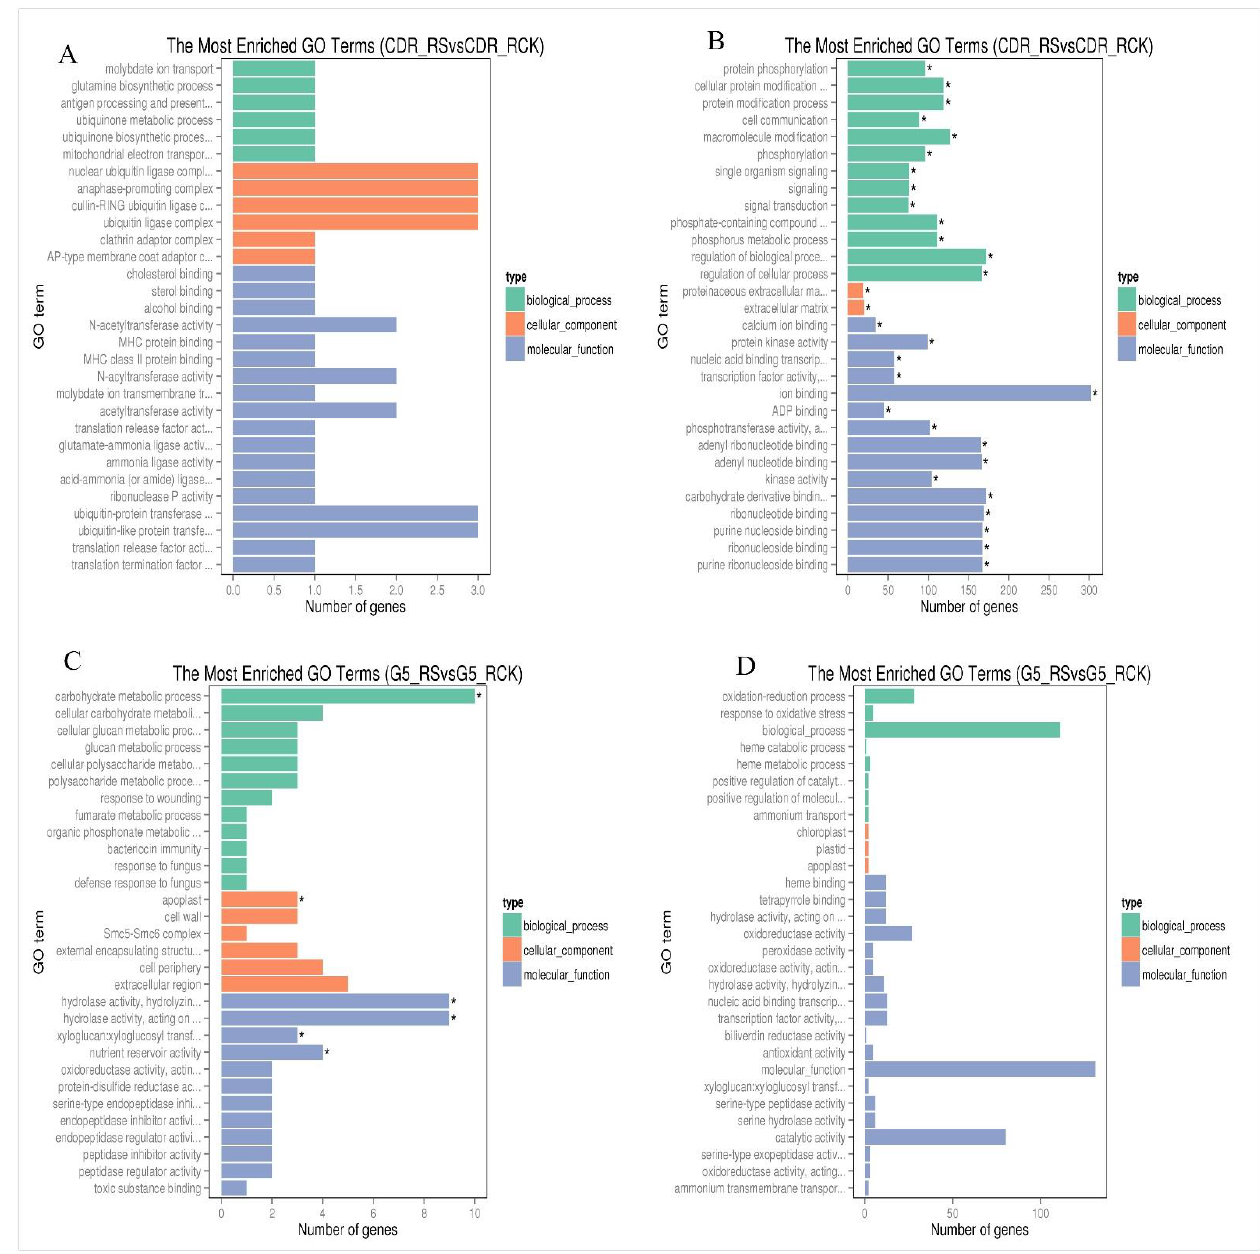
Figure 2. Functional annotation of drought-responsive genes up- and downregulated in CDR-1 and Gisela 5 root tips based on Gene Ontology (GO) categorization. ( A ) DEGs upregulated in CDR-1 roots; ( B ) DEGs downregulated in CDR-1 roots; ( C ) DEGs upregulated in Gisela 5 roots; ( D ) DEGs downregulated in Gisela 5 roots. Asterisks represent significantly enriched genes.